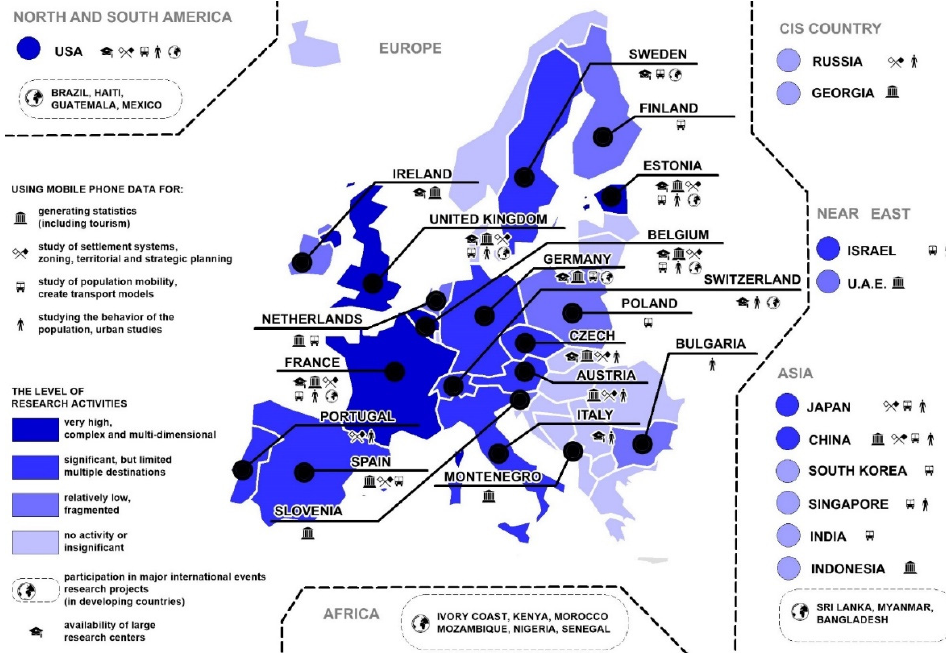
Figure 1. Geography of mobile operators’ data application. Source: [5].